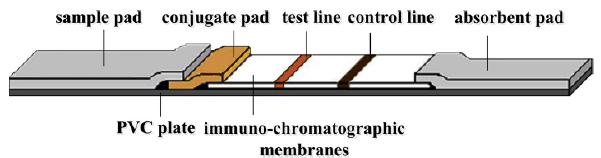
Figure 11. Schematic structure of the magnetic immuno ‐ chromatographic test strip [12]. Reprinted with permission from Elsevier 2019.